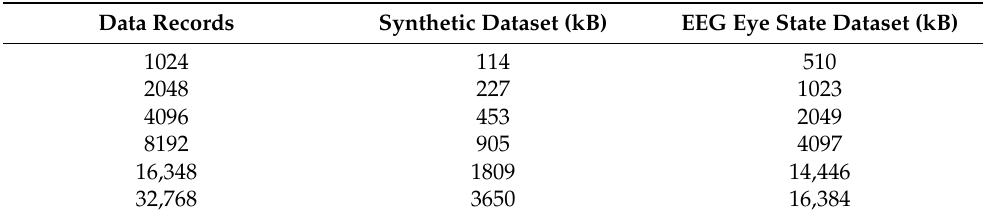
Table 2. Amount of data records and size (in kB) of the corresponding JSON (JavaScript Object Notation)